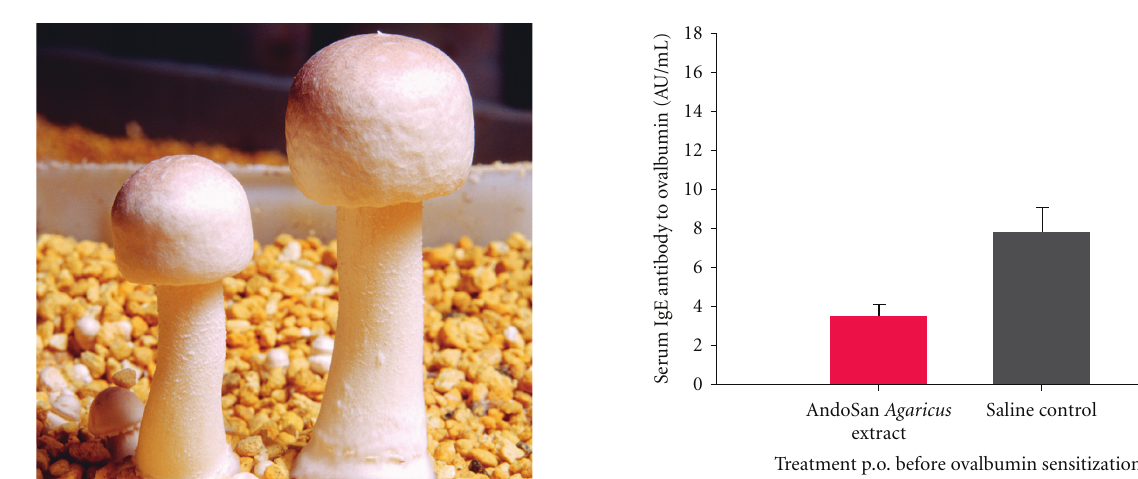
Figure 1: Agaricus blazei Murill. Photo NutriCon. The mushroom is cultivated commercially for the health food market in Japan, China, and Brazil. The AbM-based AndoSan extract is produced in Japan and developed and distributed by ImmunoPharma AS, Oslo, Norway.